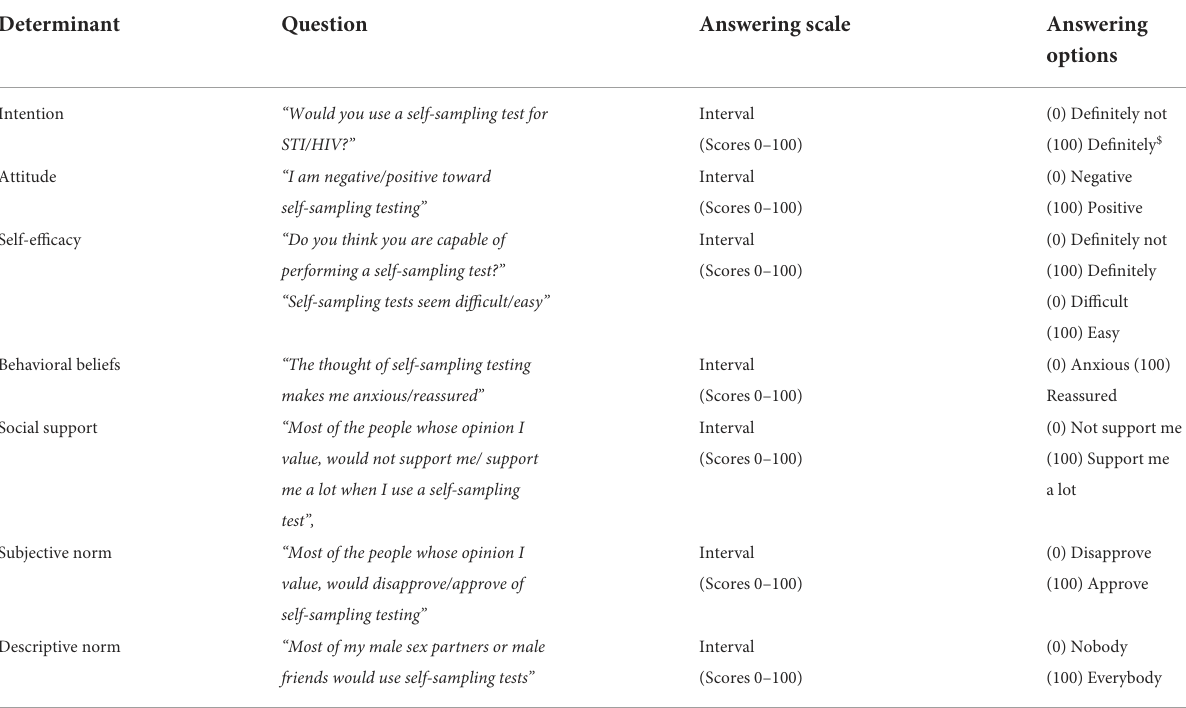
TABLE 1 Measurement of behavioral determinants of self-sampling STI/HIV